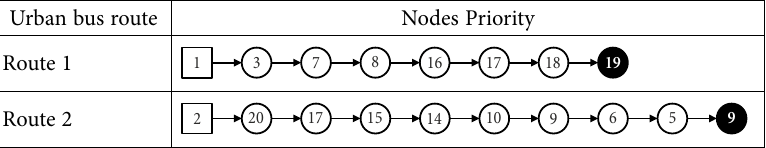
Table 3. New urban bus routes designed in scenario 2